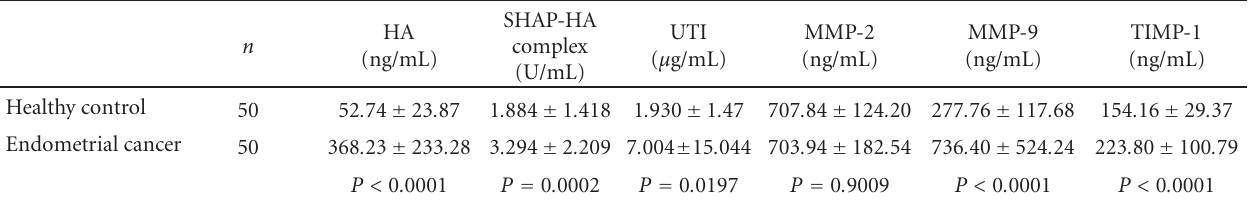
Table 2: Serum HA, SHAP-HA complex, MMP-2, MMP-9, TIMP-1, and UTI in 50 endometrial cancer patients and 50 healthy